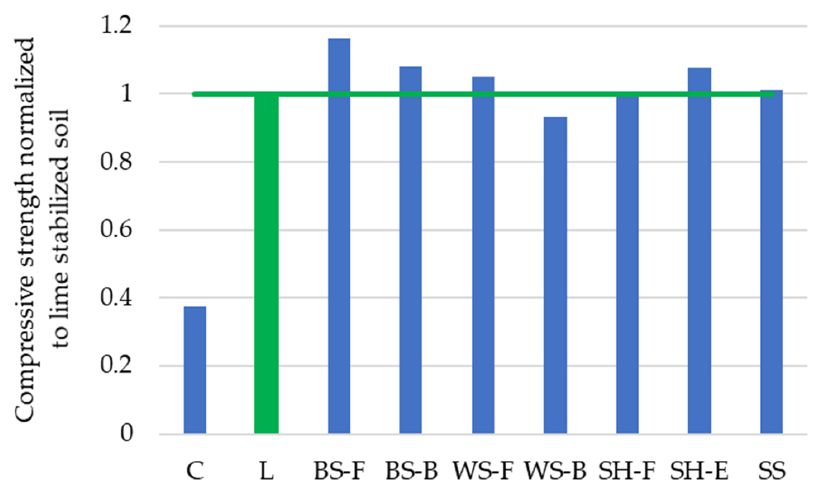
Figure 4. Normalized lime/ABA-stabilized soil compressive strength results.